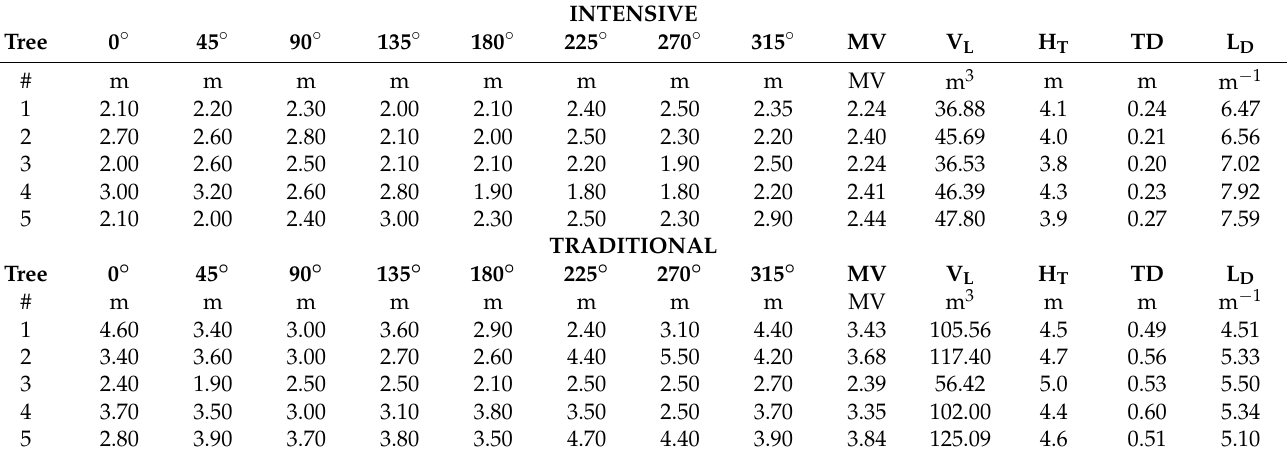
Table 3. Geometric characteristics of the sprayed trees. MV is the mean vector parameter for the MV method, as described in Section 2.1, and V L is the estimated tree crown volume. The 0 ◦ direction was the geographic North, and the rest of angular positions were placed clockwise. H T was the total tree height, TD is the trunk diameter, and L D is the leaf density (expressed in m 2 leaf surface · m − 3 canopy